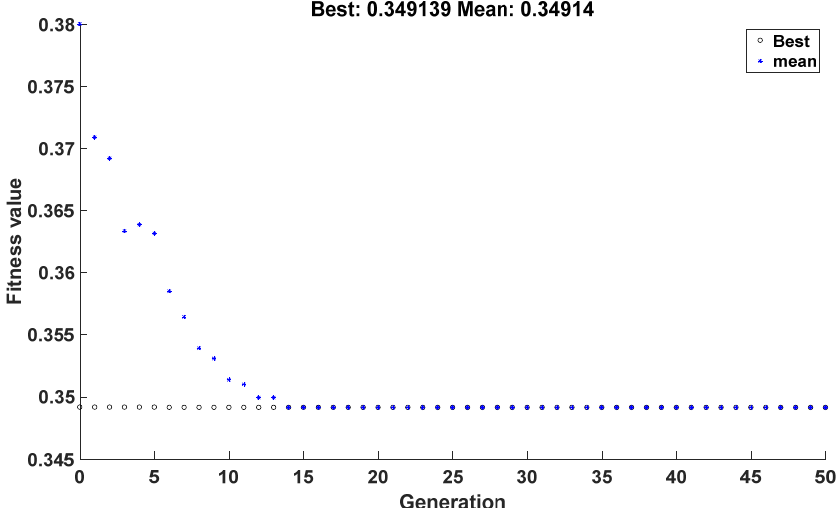
Figure 20. Iterations for finding optimal solutions. Best individuals and mean values are investigated.